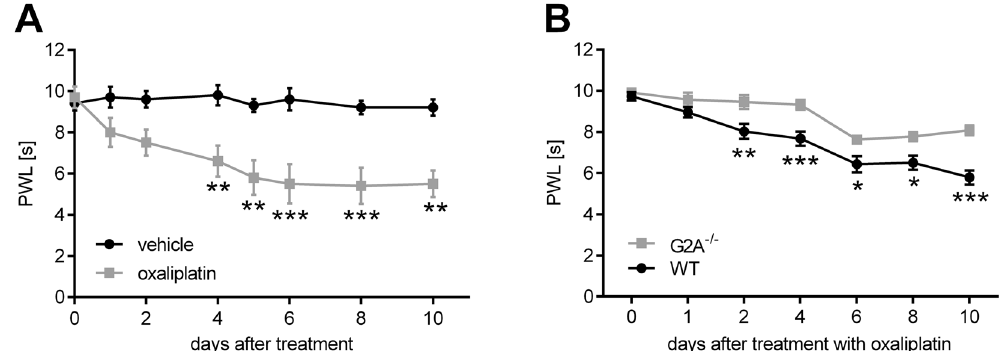
Figure 1. G2A-deficient mice have reduced oxaliplatin-induced mechanical pain thresholds. ( A ) Mechanical pain thresholds of mice after i.p.-injection of oxaliplatin (3 mg/kg) compared to vehicle (0.9% v/v DMSO) using a dynamic plantar aesthesiometer over ten days. Shown is the mean ± SEM of paw withdrawal latency (PWL) of n = 8 mice per group. ( B ) Mechanical pain thresholds of wildtype (WT) compared to G2A-deficient mice after treatment with oxaliplatin (3 mg/kg) using a dynamic plantar aesthesiometer over ten days. Shown is the mean ± SEM of PWL of n = 8 mice per group; * p < 0.05 ** p < 0.01 *** p < 0.001 two-way ANOVA with Bonferroni post-hoc